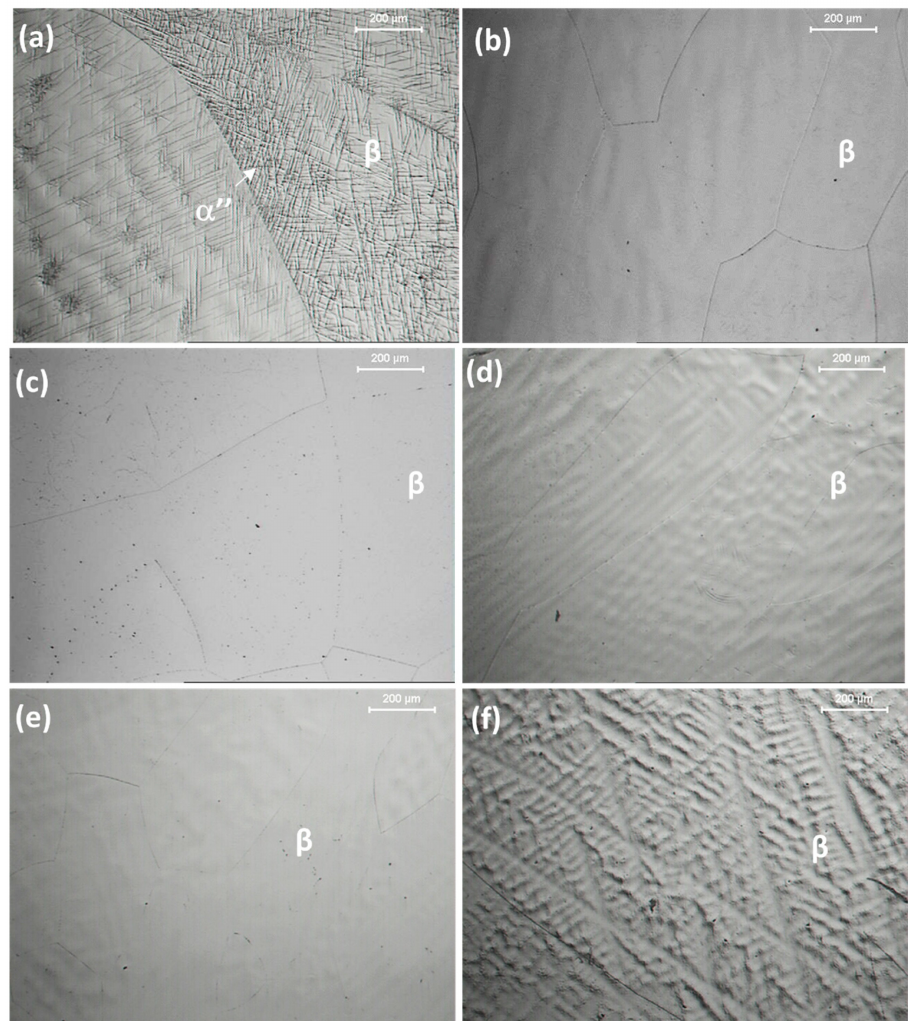
Figure 2. Optical microscopy of Ti–12Mo– x Nb alloys treated at 950 ◦ C for 1 h: ( a ) x = 0; ( b ) x = 3; ( c ) x = 8; ( d ) x = 13; ( e ) x = 17; ( f ) x =